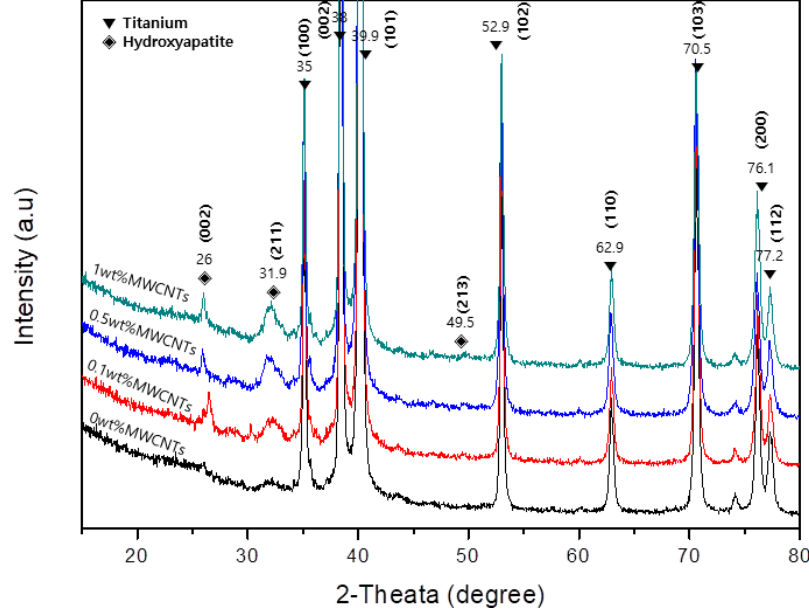
Figure 4. XRD pattern of MWCNTs-HA composites coating on titanium.